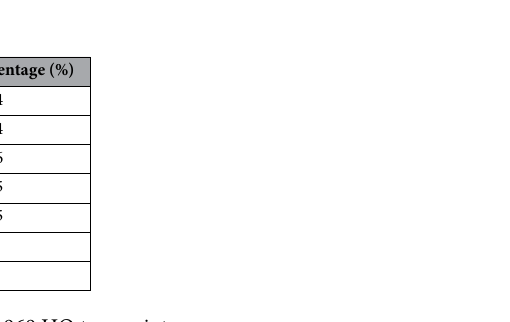
Table 1. Results of the functional annotation of 25,969 HQ